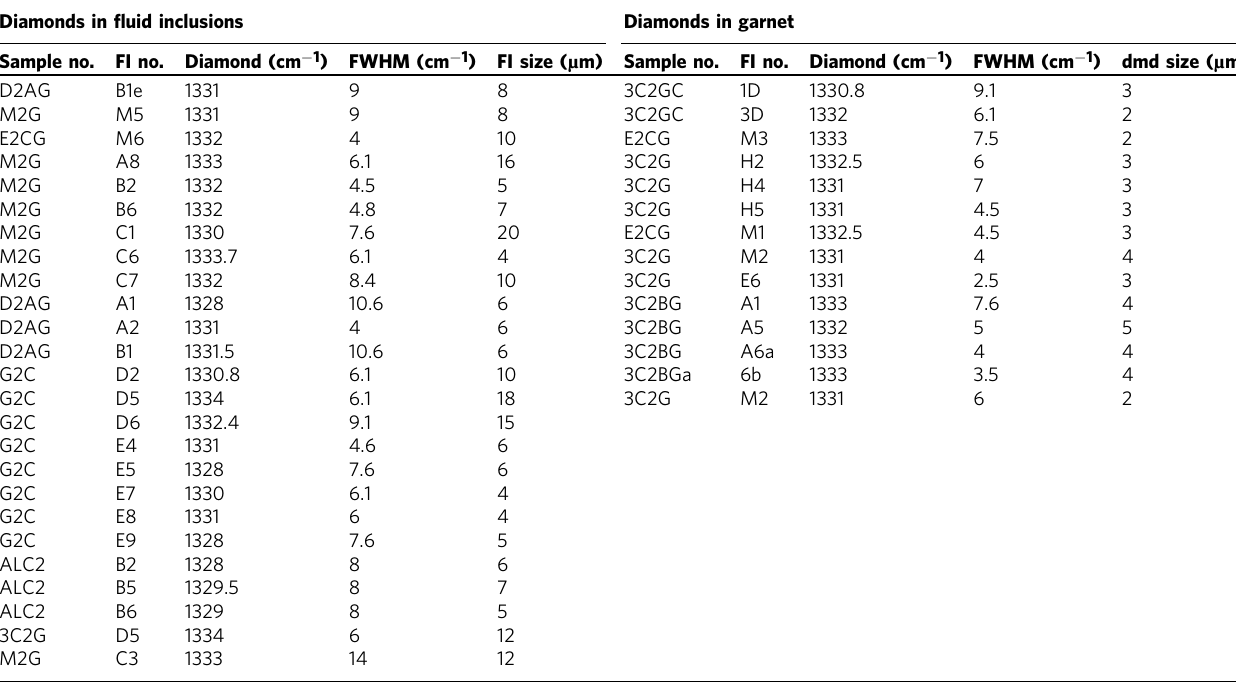
FI fl uid inclusion, FWHM full-width at half-maximum, dmd diamond a Data are from refs. 9,20